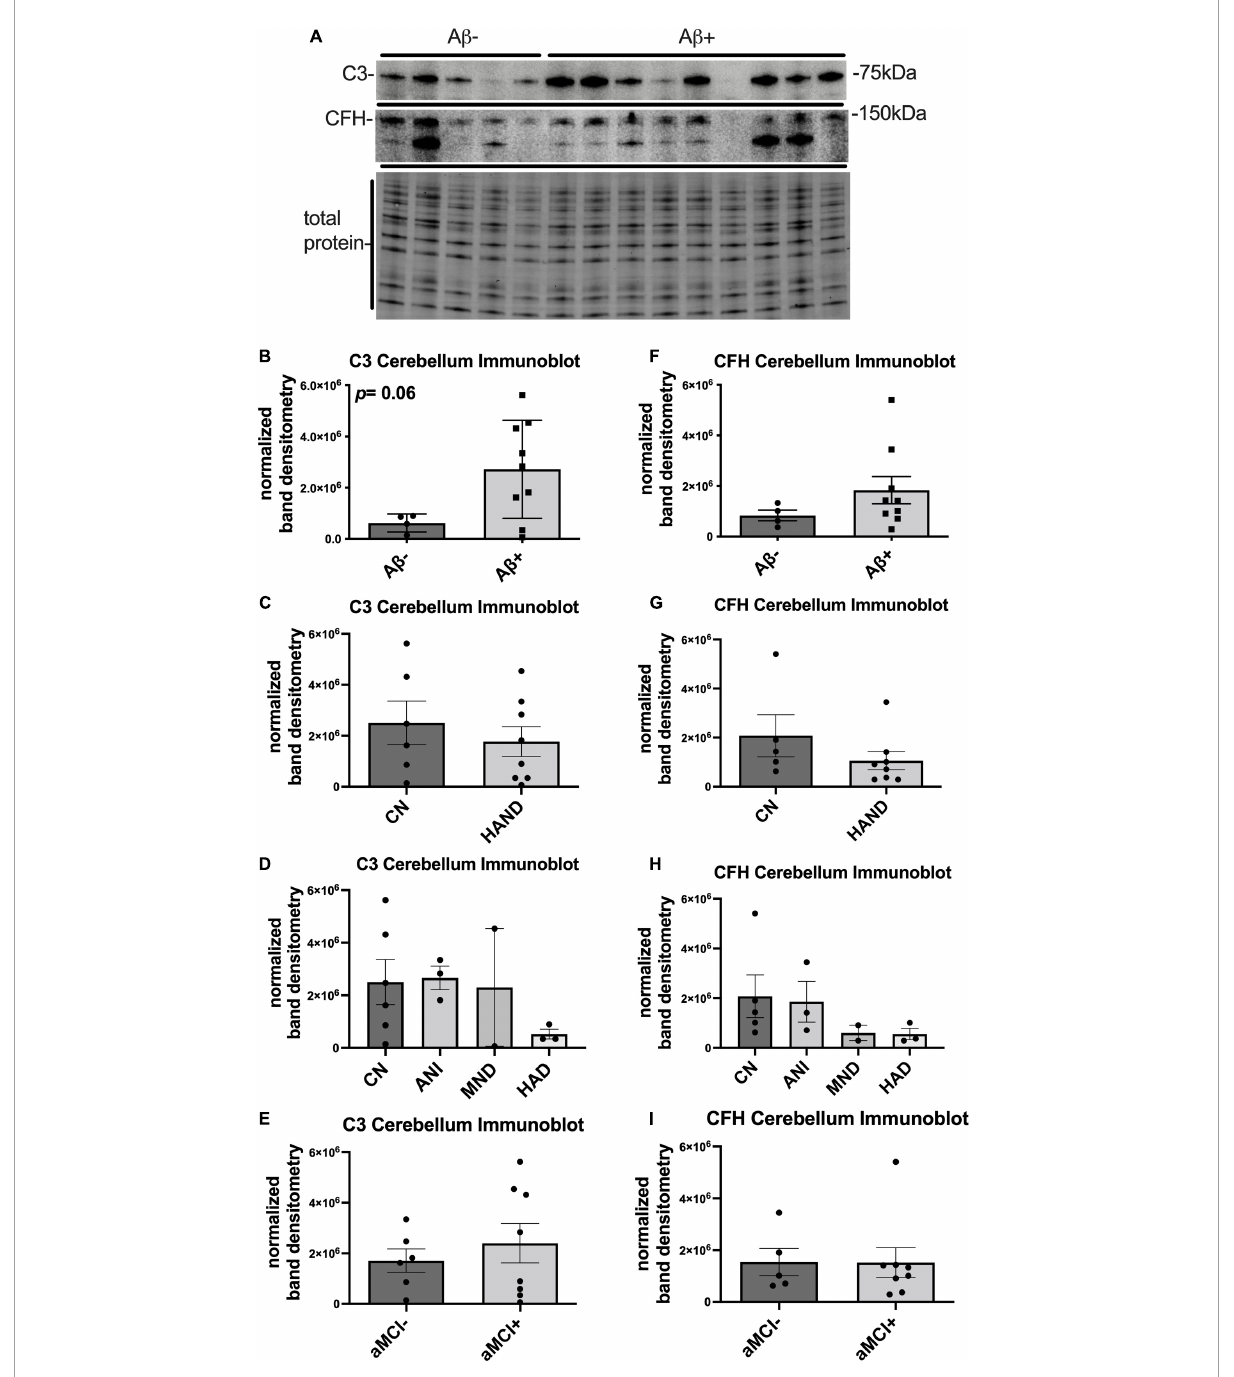
FIGURE2 C3 protein trends upward in the cerebellum HIV brains with detectable A β plaques. (A) Immunoblot for C3 and CFH and total protein transferred to the membrane using brain lysates from the cerebellum from HIV brains that were determined to be negative or positive for A β plaques. (B) Quantification of C3 band intensity normalized to total protein transferred to the membrane stratified as negative or positive for A β plaques. (C) Quantification of C3 band intensity normalized to total protein and stratified by cognitive normal vs. HAND. (D) Quantification of C3 band intensity normalized to total protein and stratified by HAND sub-categories. (E) Quantification of C3 band intensity normalized to total protein and stratified by aMCI– vs. aMCI+. (F) Quantification of CFH band intensity normalized to total protein transferred to the membrane stratified as negative or positive for A β plaques. (G) Quantification of CFH band intensity normalized to total protein and stratified by cognitive normal vs. HAND. (H) Quantification of CFH band intensity normalized to total protein and stratified by HAND sub-categories. (I) Quantification of CFH band intensity normalized to total protein and stratified by aMCI– vs. aMCI+. Statistical significance was determined by an unpaired t